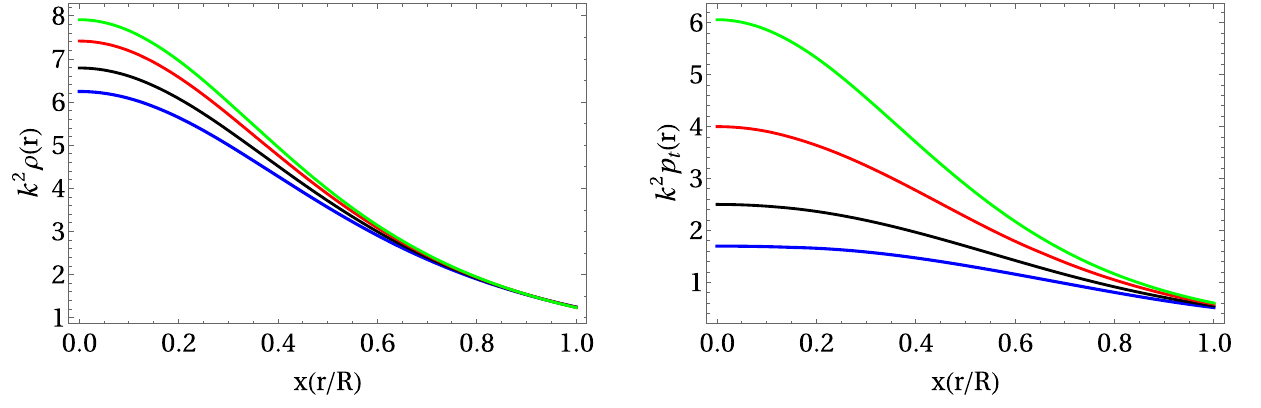
Fig. 9 Density energy for Model II for compact factors: 0.38 (blue line), 0.39 (black line), 0.40 (red line) and 0.407 (green line)